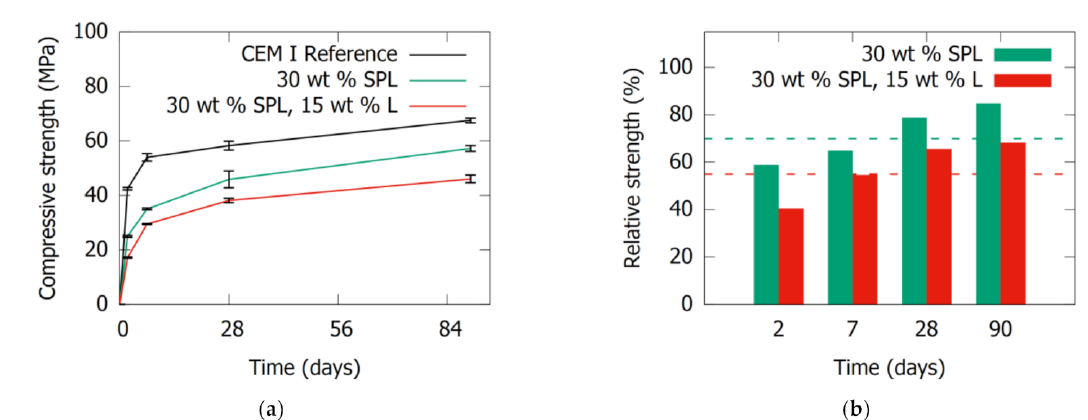
Figure 10. Compressive strength evolution of mortars with 30 wt% spent pot lining aluminosilicates (SPL) as supplementary cementitious material, including 90 days strength ( a ). The relative strength is calculated and compared to the replacement level ( b ). The replacement level is represented by a dotted line as a visual aid (in green for 30 wt% replacement—70% strength and in red for 30 + 15 wt% replacement—55% strength).